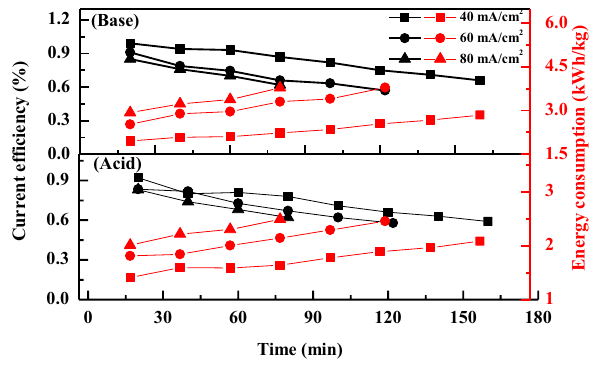
Fig. 10 The efficiency and energy consumption of HCl and LiOH at different current density